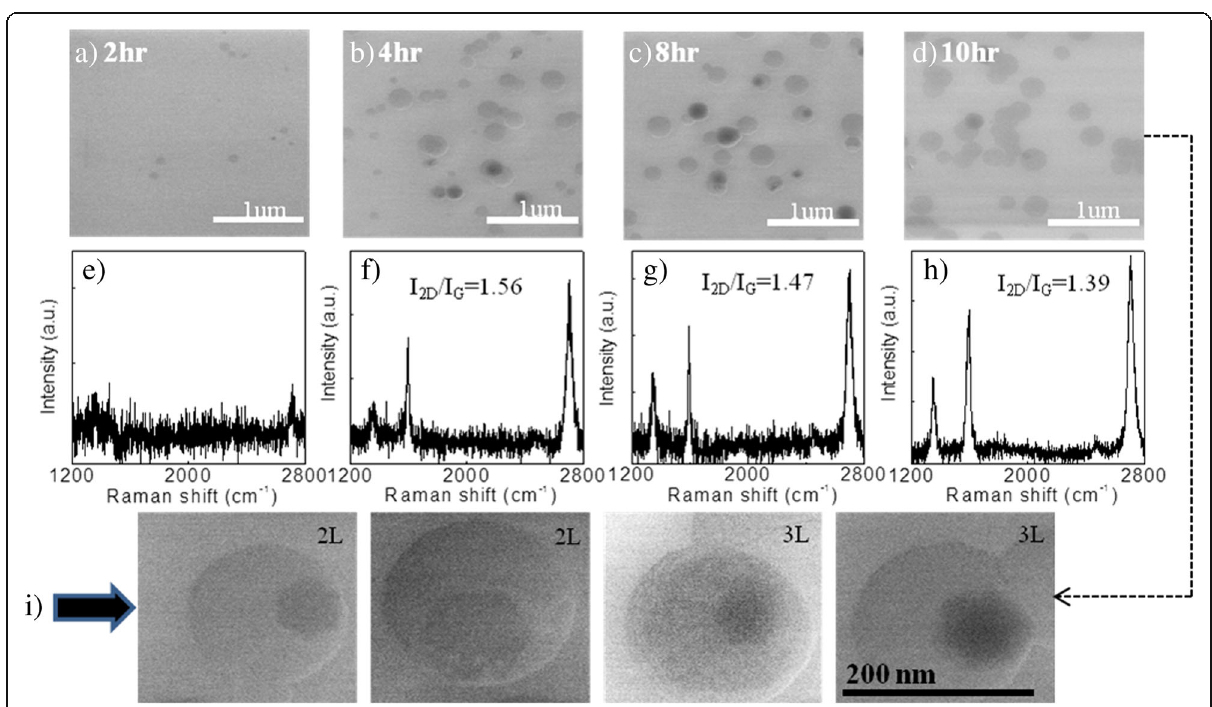
Fig. 2 SEM images of the graphene directly grown on silica at 1150 °C for growth time of a 2 h, b 4 h, c 8 h, and d 10 h. Their representative Raman spectra are shown in e – h . The I 2D / I G ratio for 4-h-, 8-h-, and 10-h-grown graphene is estimated to be 1.56, 1.47, and 1.39, respectively. Bottom panel i presents some high-magnification SEM images of bilayer and trilayer graphene flakes taken from d . The grains with larger in size and lower contrast are first graphene layers, and those with smaller in size and higher contrast correspond to the second and third layers. The scale bar is the same for